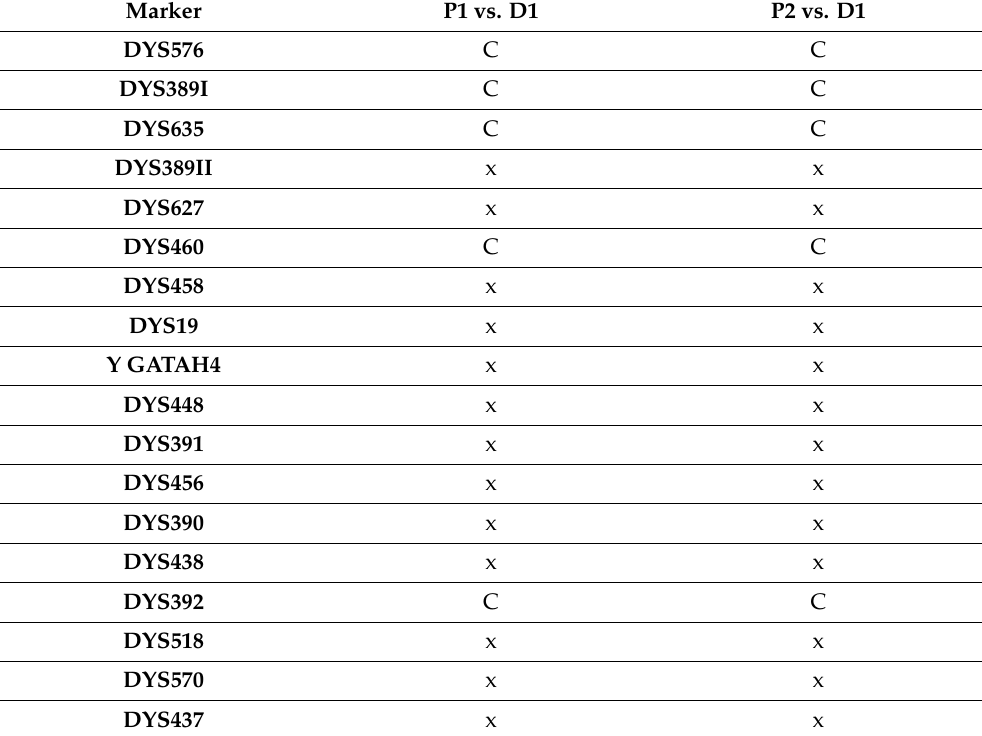
Table 2. Results of the Y-STR haplotype concordance study between NN male and nephews of Michal Mosur.